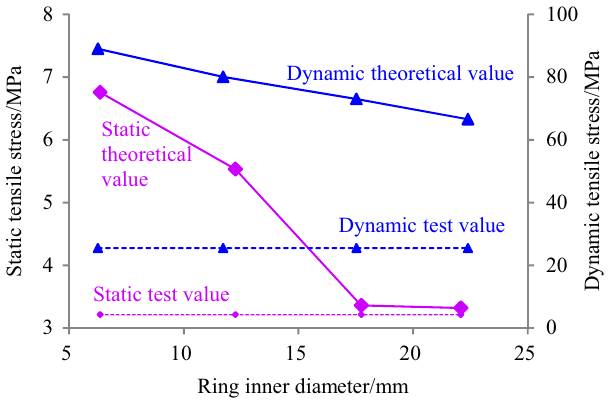
Figure 9. Verification diagram of static and dynamic failure criteria of circular